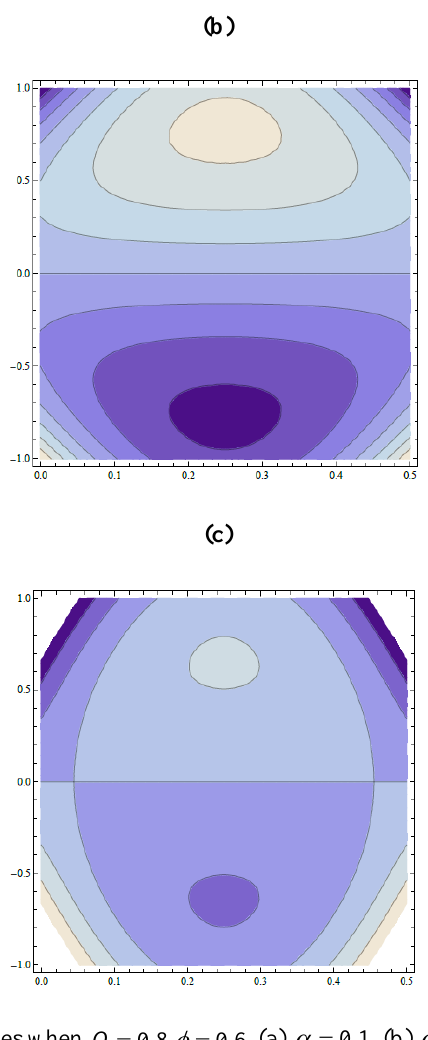
Fig. 14. Stream lines